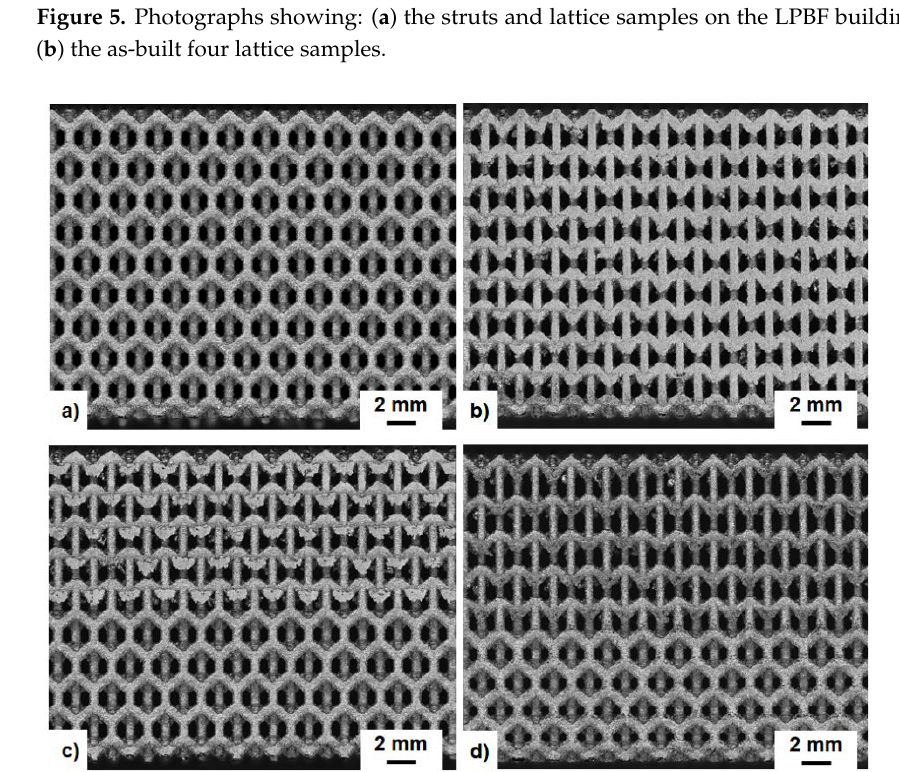
Figure 6. The optical microscope images of the LPBF-manufactured cellular lattice structures with the same relative density: PPR ( a ), NPR ( b ), HPR ( c ) and FGHPR ( d ). BD refers to the building di- rection .